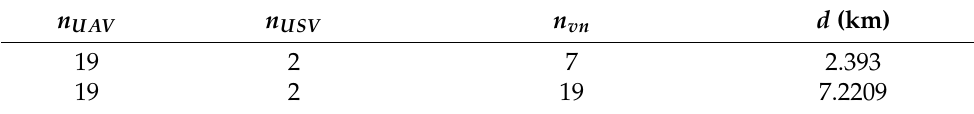
Table 13. Parameters used in the simulations for LB = 106 dB and LB = 115